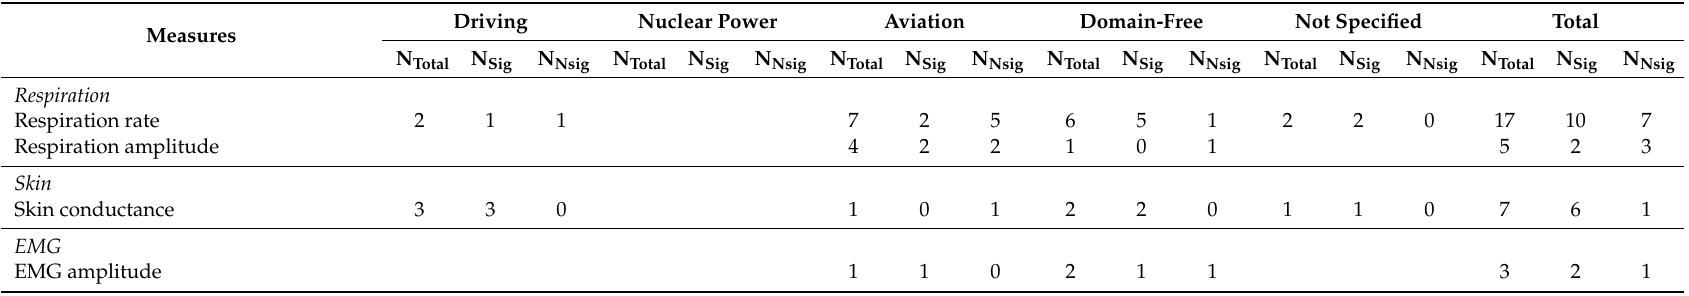
Table 7. Summary of respiration, skin, EMG and neuroendocrine measures and their statistical significance reported in the reviewed